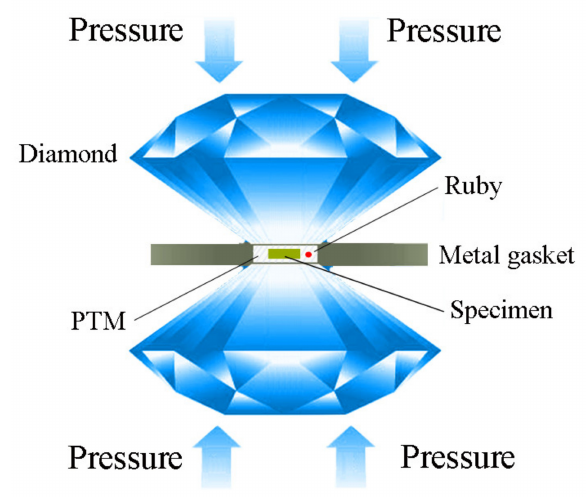
Figure 1. Schematic of DAC for high-pressure studies.